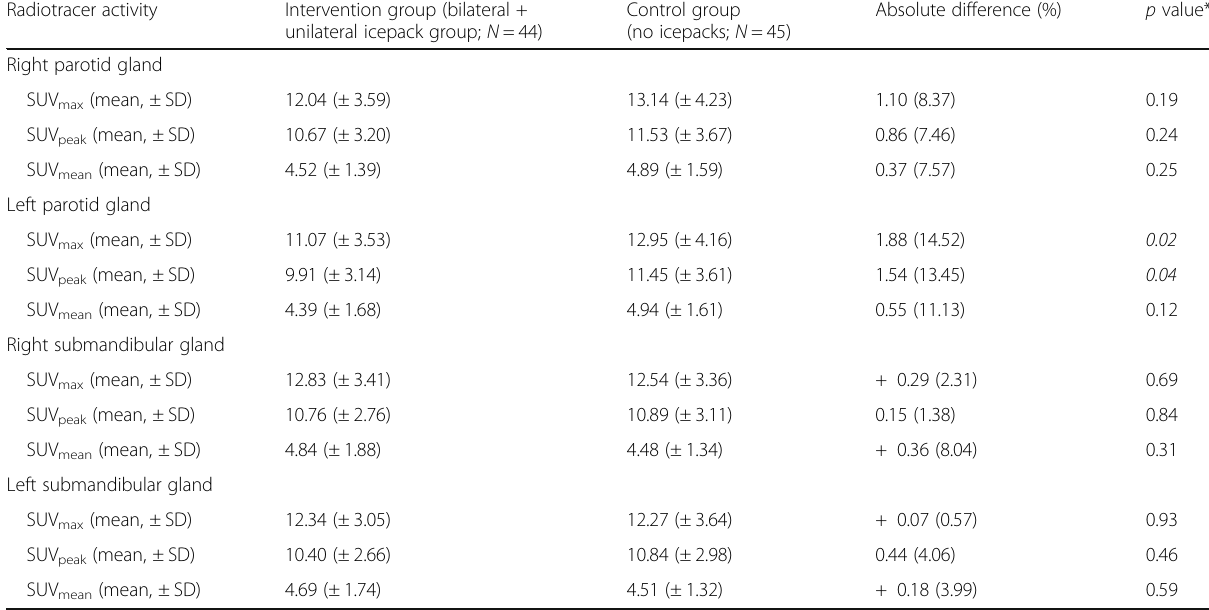
Table 2 Radiotracer activity in salivary glands of the intervention group (bilateral + unilateral icepacks-group) versus control group (no icepacks) Radiotracer activity